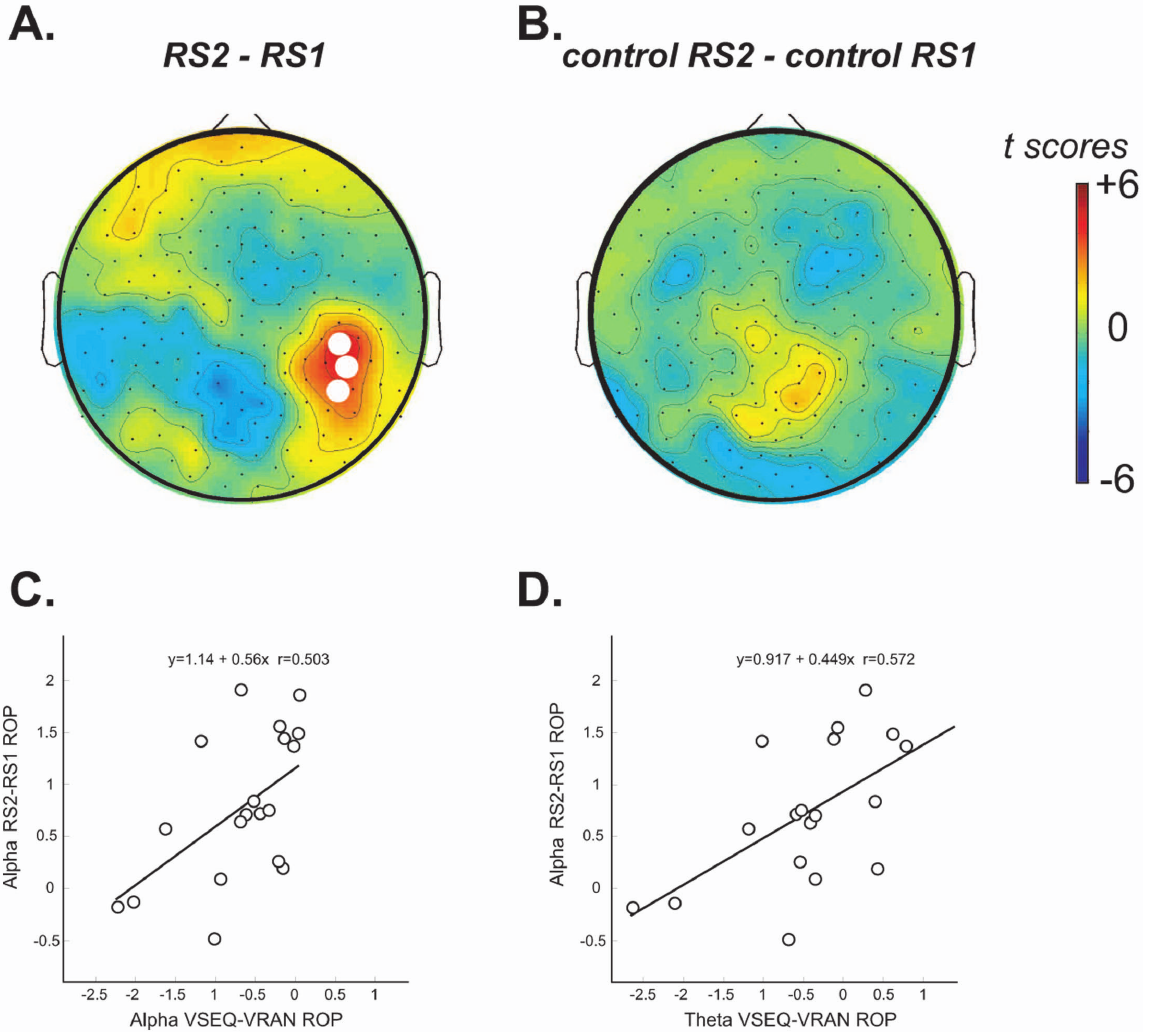
Figure 5. Resting state naTop row: Changes in spontaneous resting state EEG after forty-minute sequence learning tasks (A.) and after forty-minute performance in a variety of different motor tasks (B.). White circles indicate electrodes with significant power differences between RS2 and RS1. Bottom Row: Correlations between the changes in resting state EEG (alpha range) and the VSEQ-VRAN changes observed 250 ms pre- and post-stimulus in the alpha (C) and theta ranges (D).